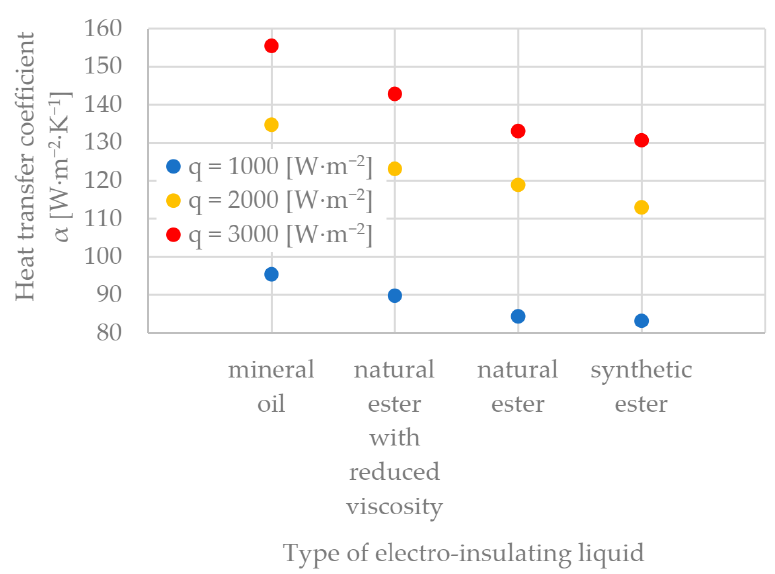
Figure 6. The heat transfer coefficient α depending on the type of electrically insulating liquid for different values of the heat load of the cooled surface q and the length of the heating element δ = 0.8 m.